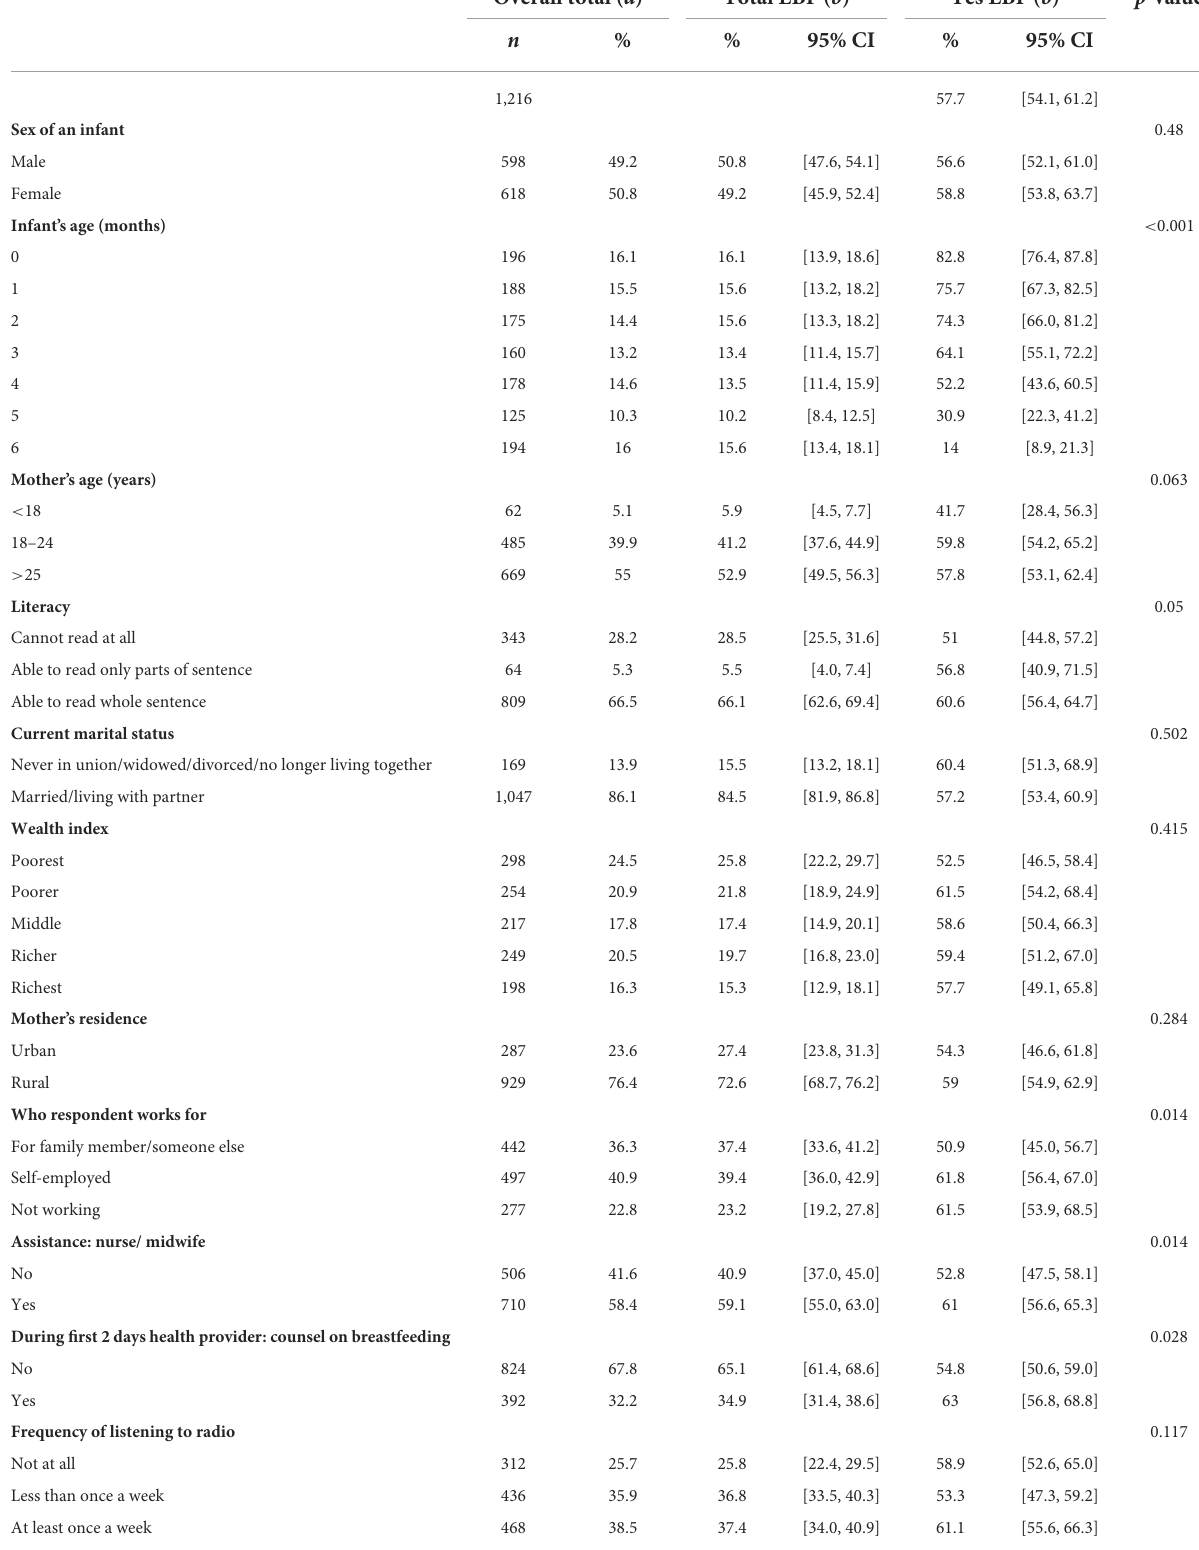
TABLE 1 Background characteristics of the participants ( N =